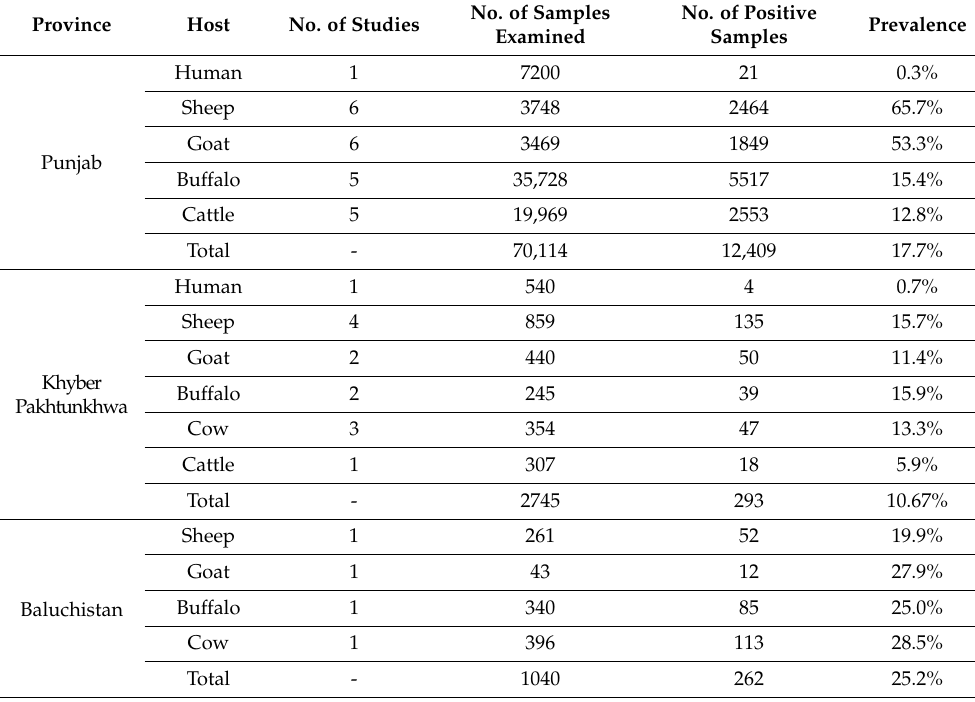
Table 3. Geographical distribution and prevalence of Fasciola spp. in different